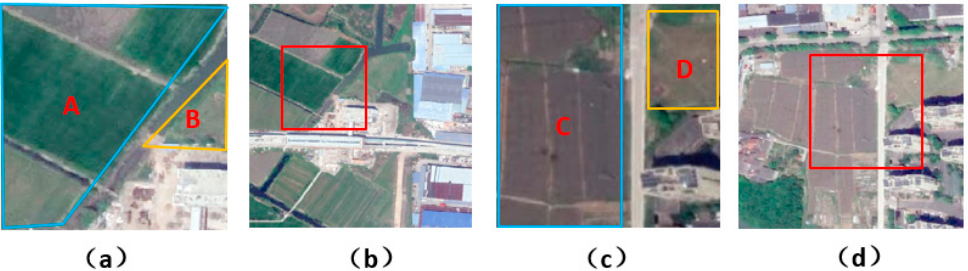
Figure 2. Examples of “different objects with the same spectrum”. ( a , c ) are two samples; ( b , d ) are corresponding surrounding environment of ( a , c ). In ( a , c ), the feature of city grass (in B) is similar to flat_field (in A). Meanwhile, in ( c ), the city_grass (in D) is similar to flat_field (in C). As in Figure 2, flat_field and city_grass are “different objects with the same spec- trum”, a large number of flat_fields will cause the misclassification of city_grass.